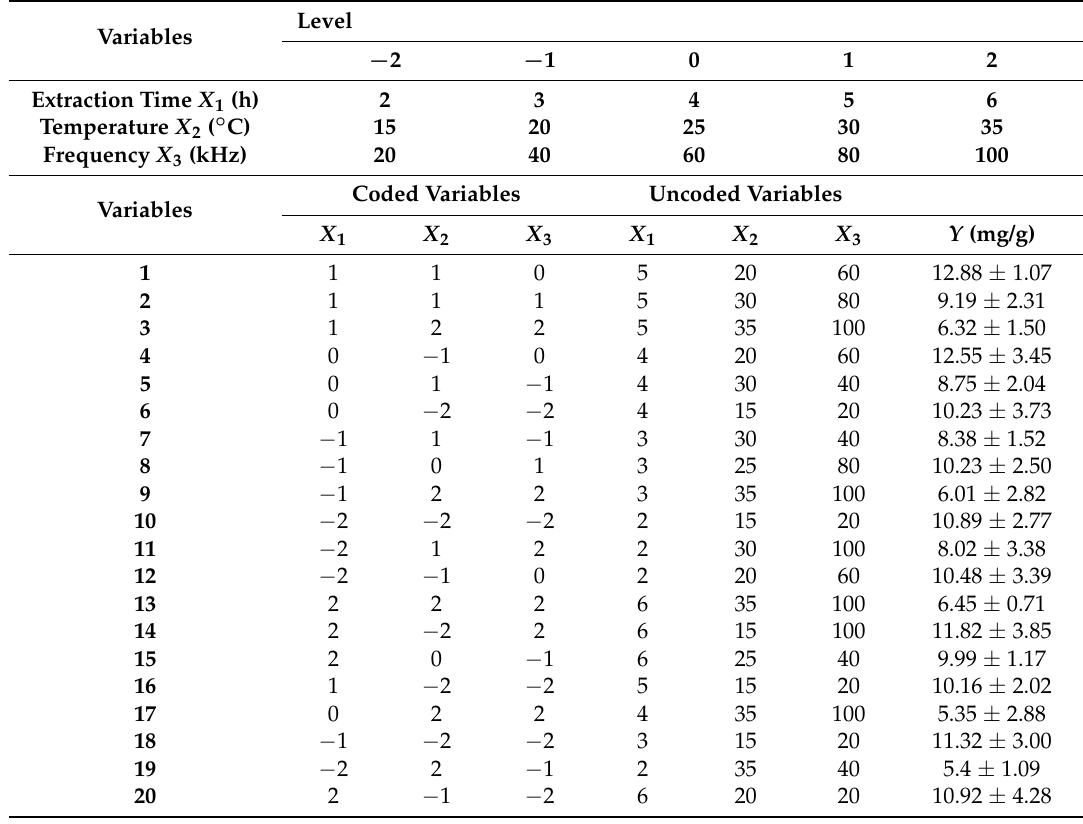
Table 1. Results of estimating C3G contents in the extracts by the central composite experimental